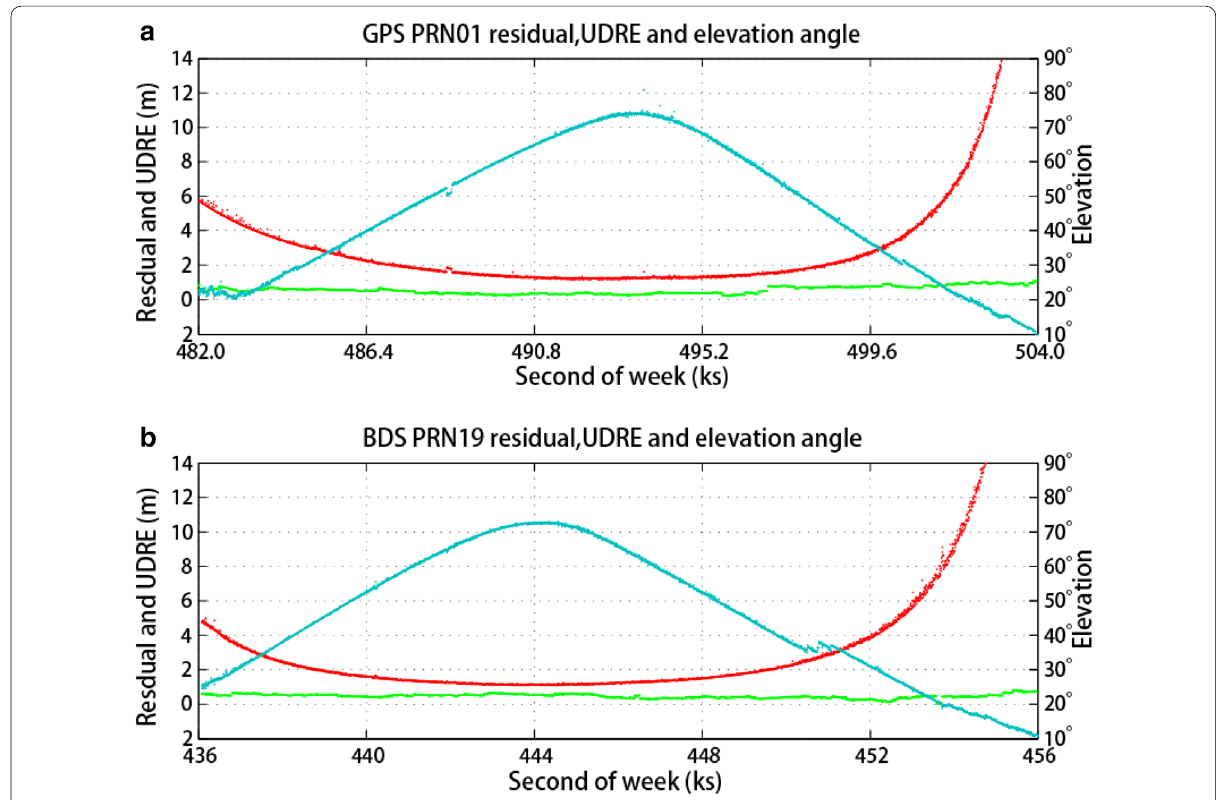
Fig. 14 UDRE integrity of GPS PRN01 and BDS PRN19